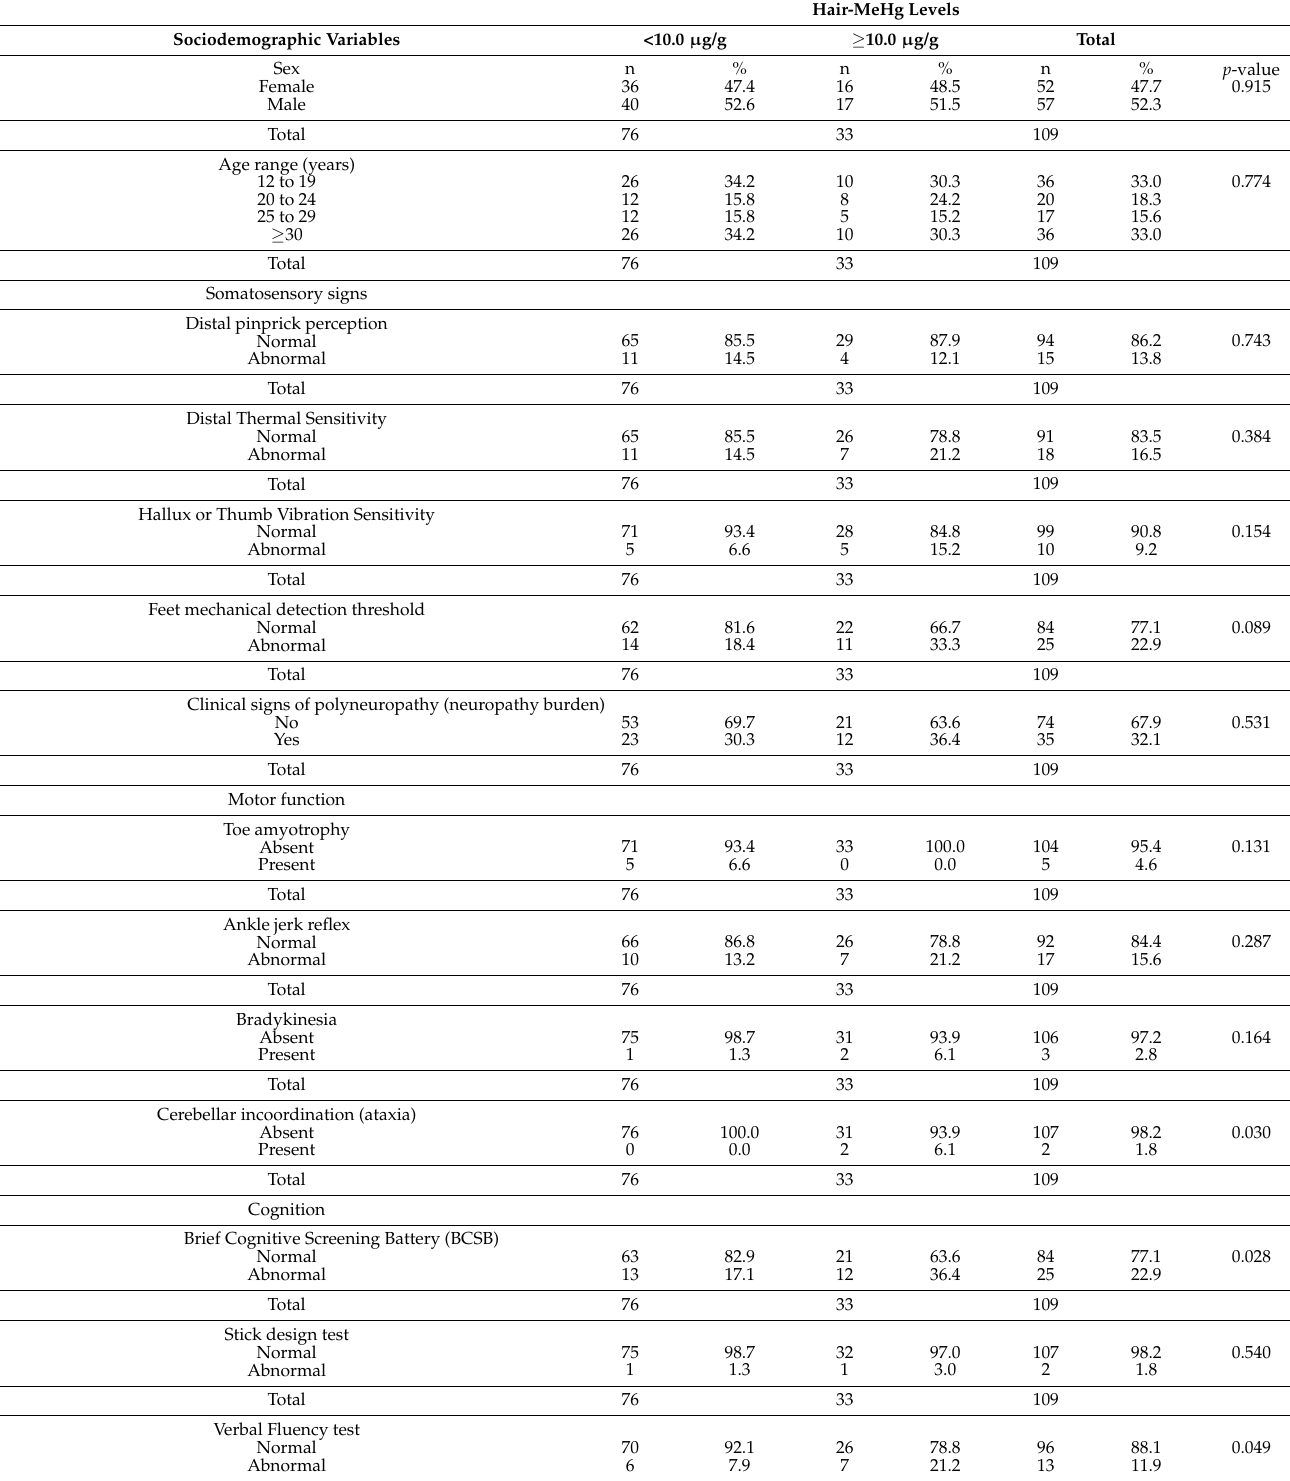
Table 2. Sociodemographic variables, somatosensory and motor functions, and cognition signs, according to hair-MeHg levels (<10 vs. ≥ 10 µ g/g), Sawr é Muybu Indigenous Land, Par á state, Brazilian Amazon,